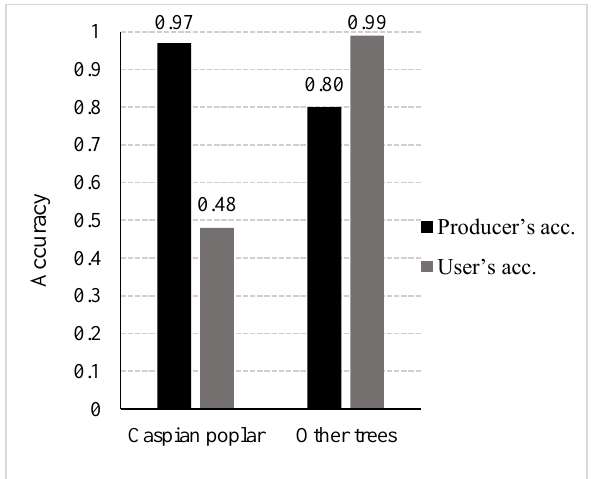
Figure 5 . Producer’s and User’s accuracy of Caspian poplar and other trees classes